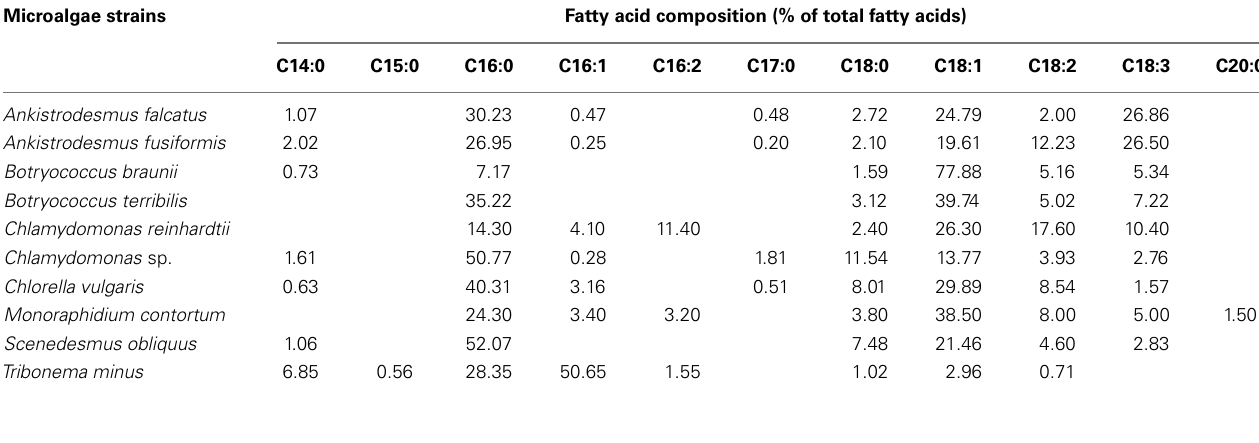
Table 2 | Fatty acid profiles (% of total fatty acids) of different microalgae strains under regular phototrophic growth conditions (Bogen et al., 2013; Nascimento et al., 2013;Wang et al., 2013) . Microalgae strains Fatty acid composition (% of total fatty